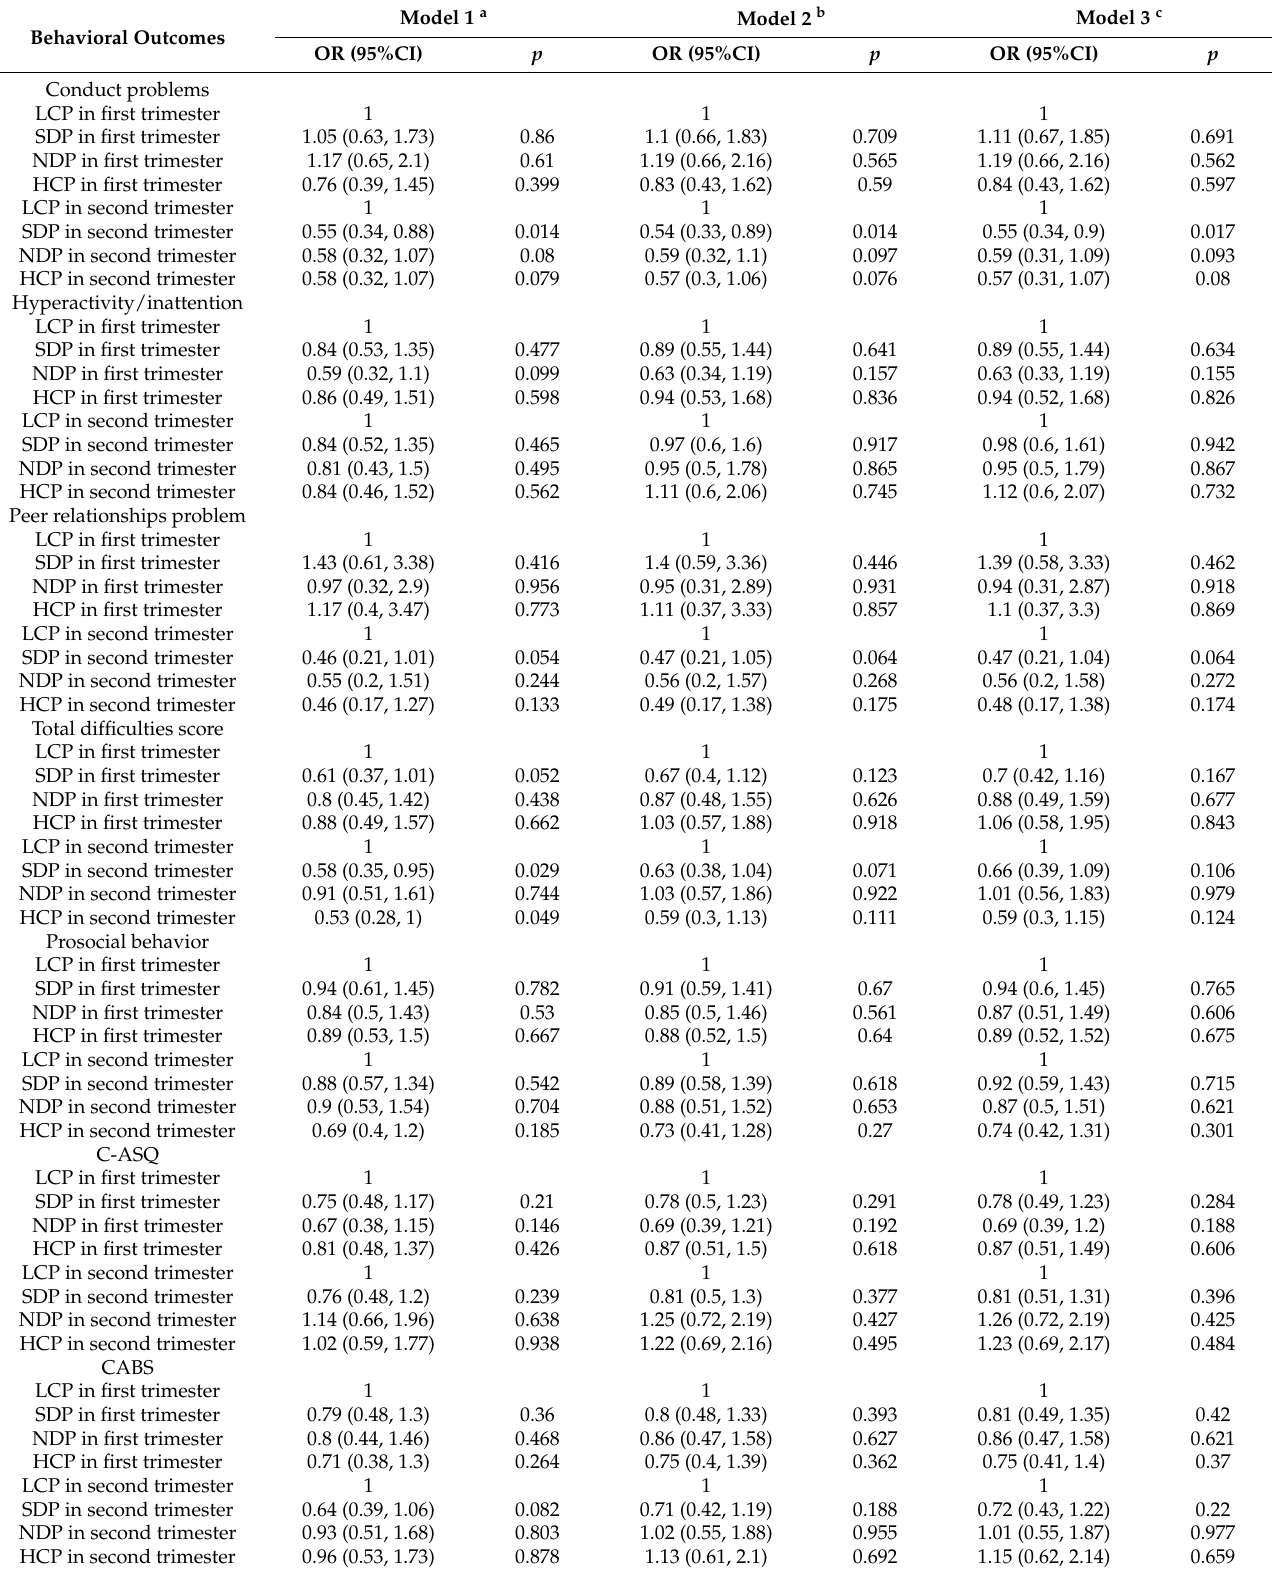
Abbreviations: LCP, Low-consumed pattern; SDP, Southern dietary pattern; NDP, Northern dietary pattern, CABS, Clancy Autism Behavior Scale; C-ASQ, Conner’s Abbreviated Symptom Questionnaire. a: Model 1 includes maternal dietary patterns in first and second trimester; b: Model 2 includes covariates such as child gender and age, maternal education, residence, maternal age, pregestational BMI, and monthly income; c: Model 3 takes into account maternal depression during pregnancy on the basis of model